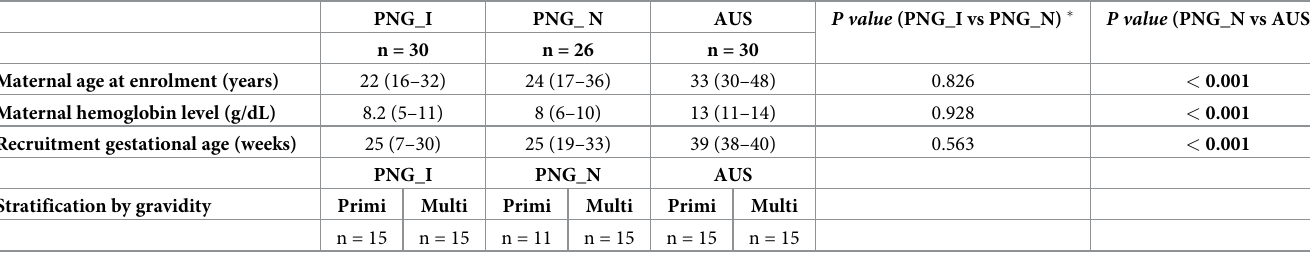
Table 1. Clinical characteristics and stratification of study